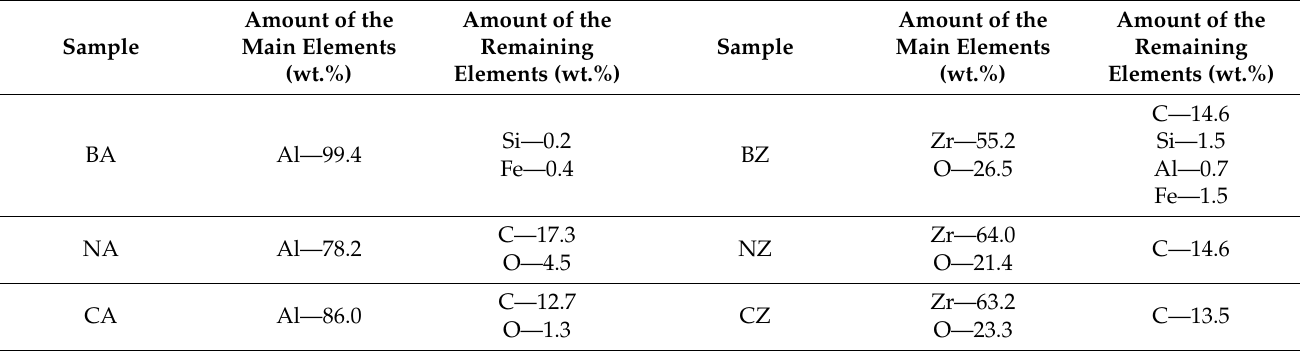
Table 4. Chemical composition of fabrics